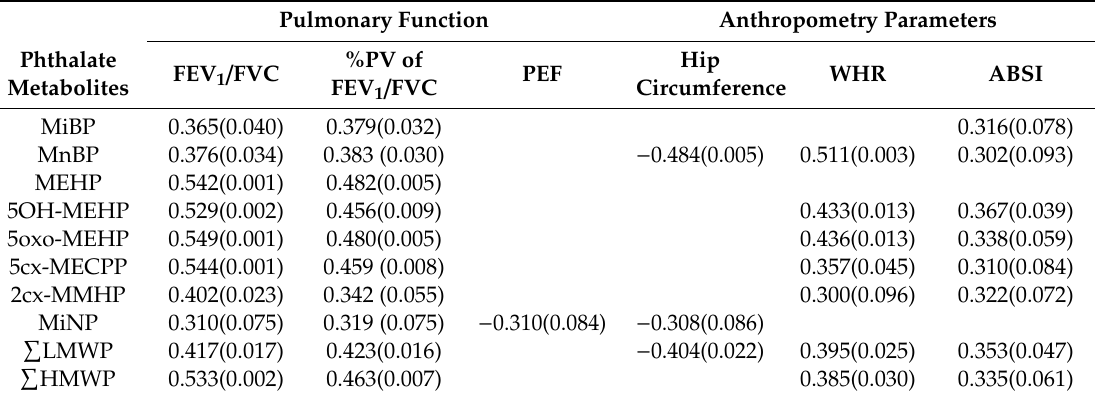
Table 7. Bivariate analysis between phthalate metabolites and PFT and anthropometry in firefighters ( n = 32), Spearman correlation coe ffi cient ( p